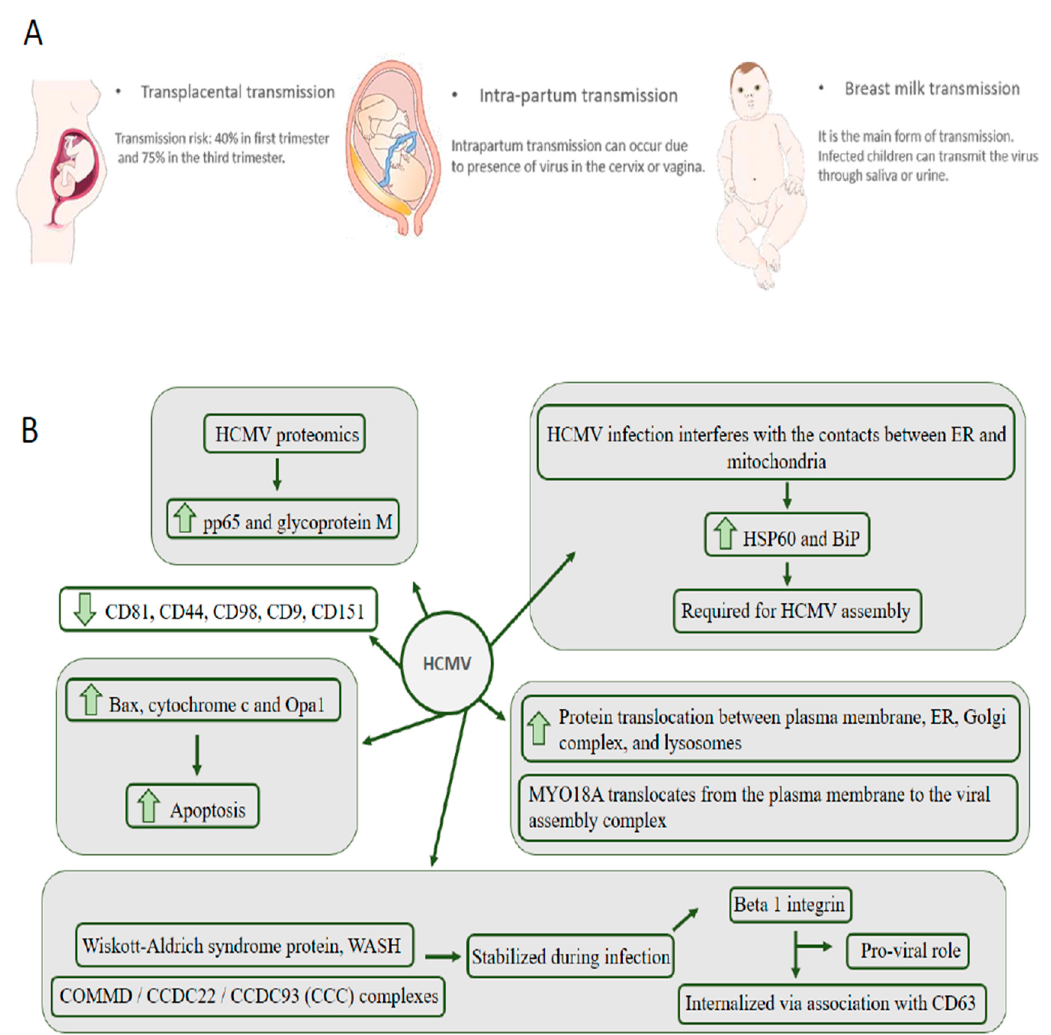
Figure 2. Main forms of maternal–fetal transmission of cytomegalovirus ( A ). Main findings indicated by proteomic studies that explore the proteome of human cytomegalovirus (HCVM) infection ( B ). 3. ZIKV: In 2015, the World Health Organization Reported Cases of Neurological Disorders in